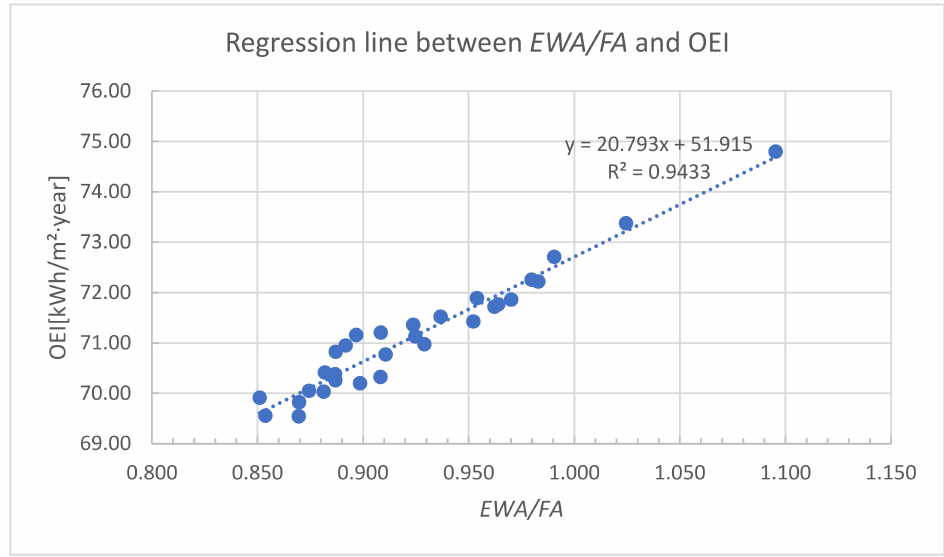
Figure 2. High degree of regression line fit as an approximation of the linear dependence of the OEI dependent variable on the independent EWA / FA